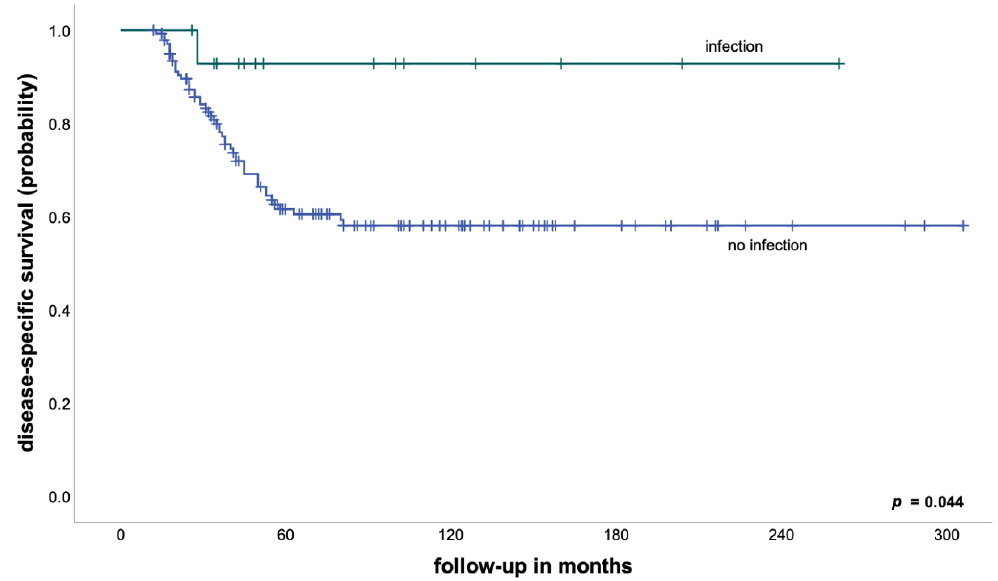
Figure 2. Disease-specific survival in patients with a poor response to neoadjuvant chemotherapy according to the development of an early postoperative infection .